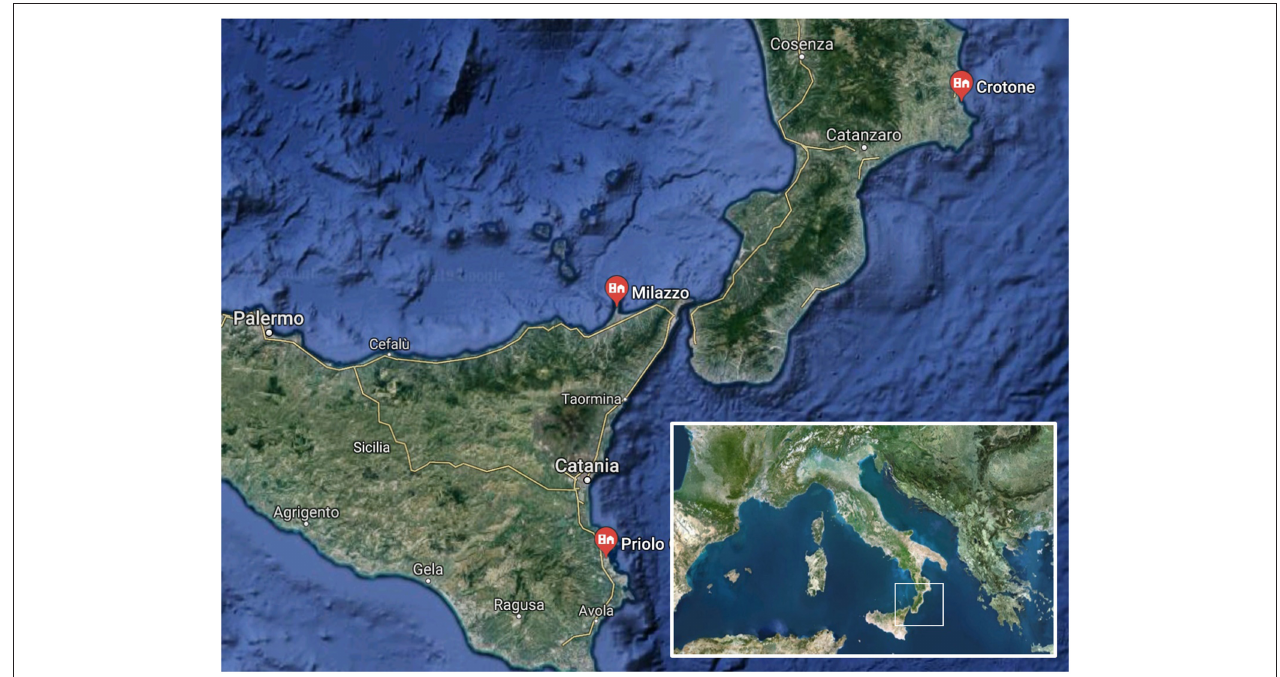
FIGURE 1 | Map of the investigated AERCA sites generated from google map